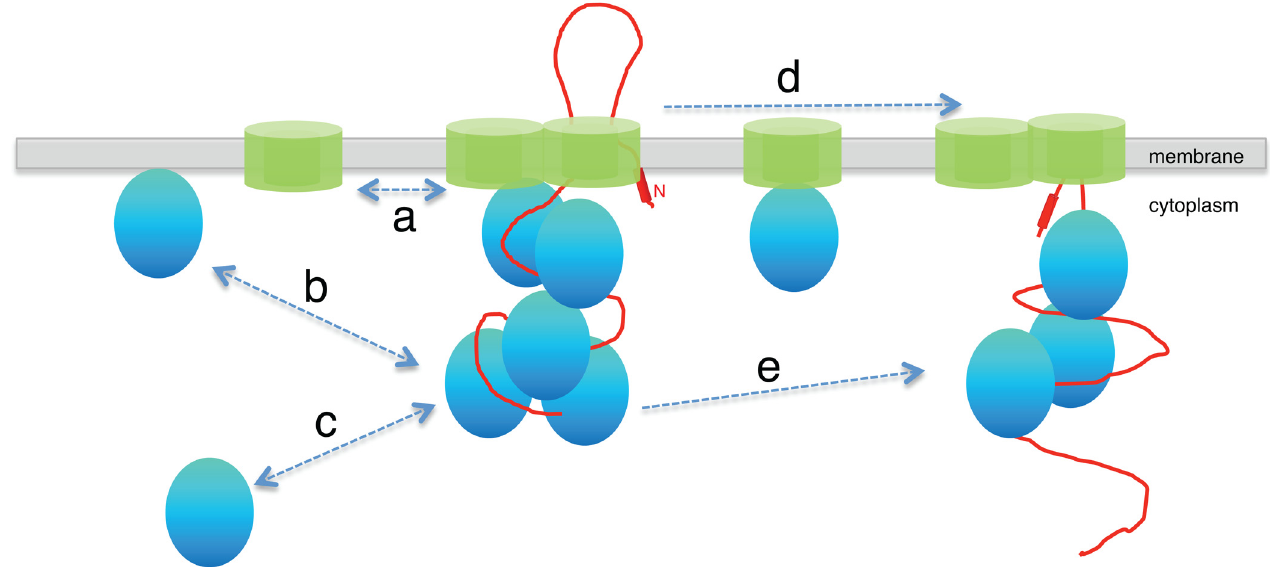
Fig 5. Model of the secretory machinery. The SecYEG translocon (in green) is comprised SecYEG molecules which are engaged in cycles of association and dissociation with the SecY molecules on the membrane (a). SecA (shown in blue) delivers the pre-protein (shown in red) destined for export across the membrane to the translocon, where multiple molecules of SecA associate and accumulate during translocation. This association is dynamic because molecules of SecA exchange with the surrounding free molecules on the membrane (b) and in the cytoplasm (c). The SecYEG heterotrimer moves between neighboring translocons only when complexed with other proteins, such as SecA (d). A single SecA molecule can sequentially engage with neighboring SecYEG complexes (e).